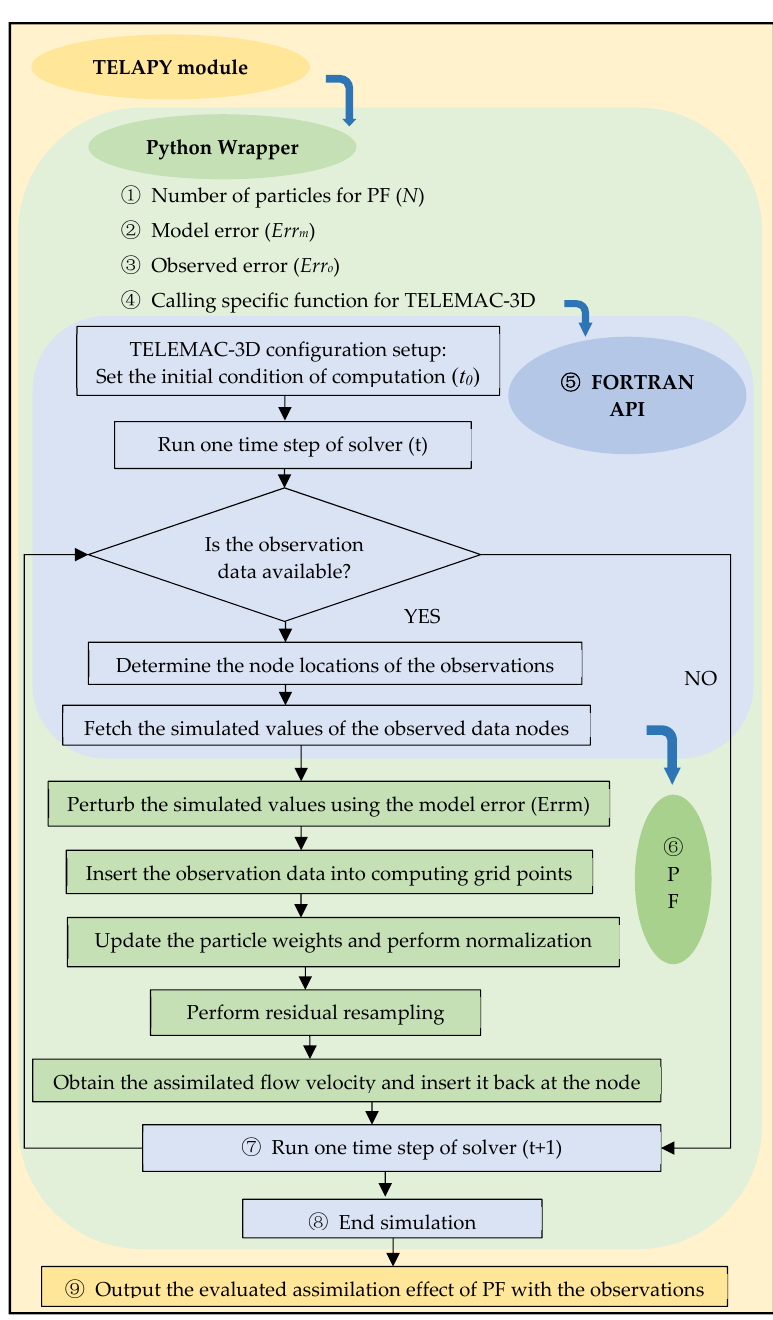
Figure 4. The flowchart of the proposed DA scheme for soft velocity measurement coupled with the TELEMAC-3D model and